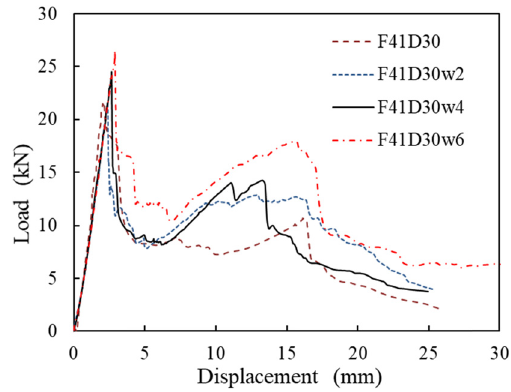
Figure 9: Effect of the number of FRP web